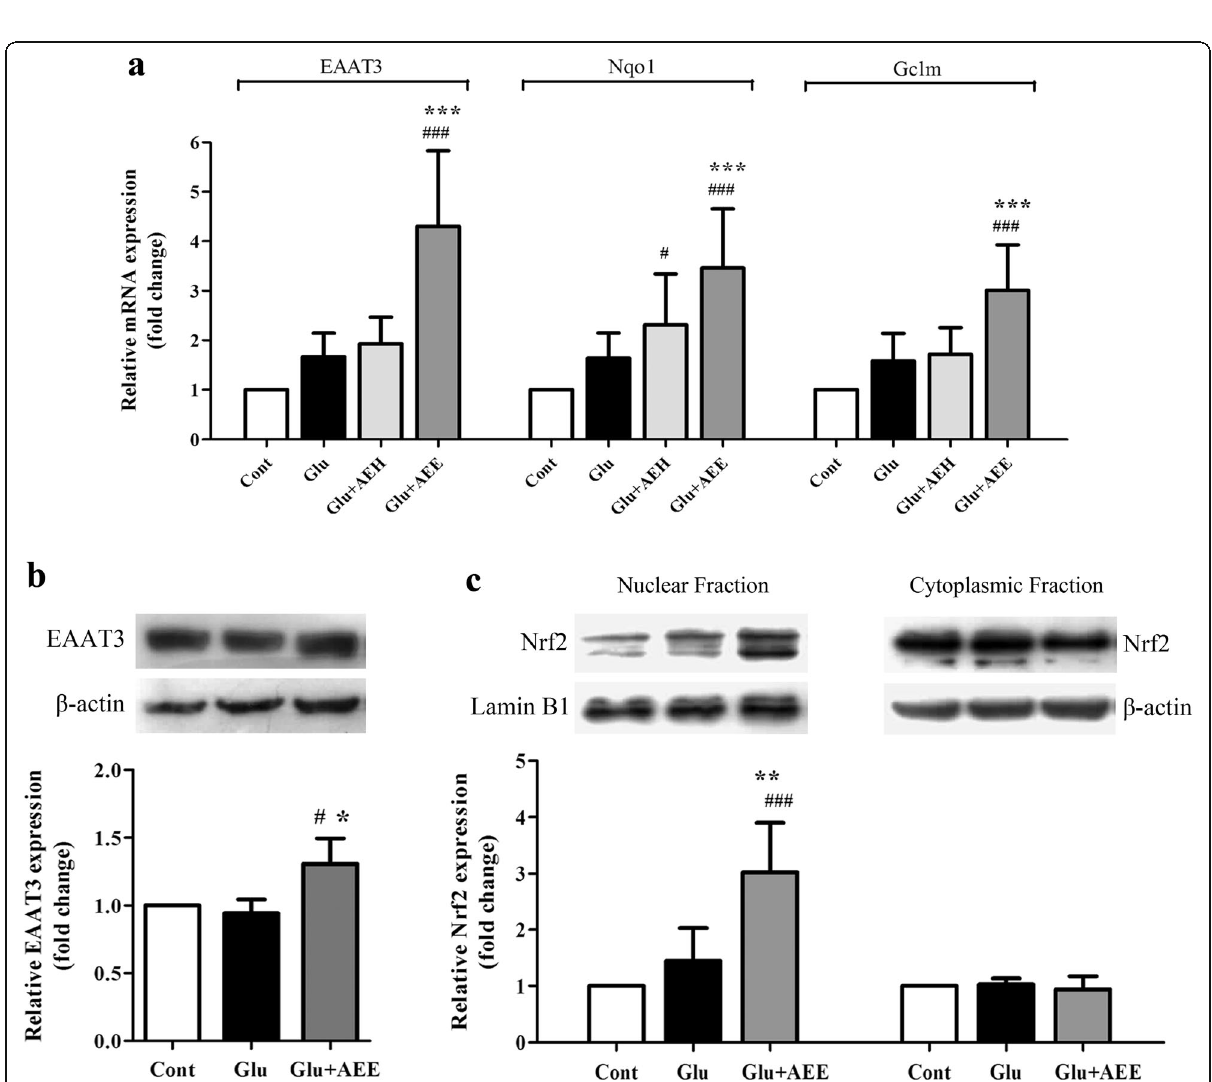
Fig. 6 Effect of AE leaf extracts on expression of Nrf2-regulated antioxidant genes in glutamate-treated HT22 cells. ( a ) Quantitative real-time RT PCR analysis of EAAT3, Nqo1, and Gclm mRNA expression in untreated HT22 cells (control) or cells exposed to 5 mM glutamate alone or glutamate combined with either AEH or AEE at 50 μ g/mL for 20 h. β -actin served as an internal control to normalize the mRNA expression levels. ( b ) Western blot analysis of EAAT3 protein in whole cell lysates isolated from untreated HT22 cells (control) or cells exposed to 5 mM glutamate alone or glutamate combined with 50 μ g/mL AEE for 22 h. ( c ) Western blot analysis of Nrf2 protein in nuclear and cytoplasmic fractions isolated from HT22 cells exposed for 1 h to the similar treatment conditions as in ( b ). Lamin B1 and β -actin were used as endogenous loading controls to normalize the protein expression levels from nuclear and cytoplasmic fractions/whole cell lysates, respectively. Data are expressed as the means ± SD, # P < 0.05, ### P < 0.001 vs. control; *P < 0.05, **P < 0.01, ***P < 0.001 vs. glutamate